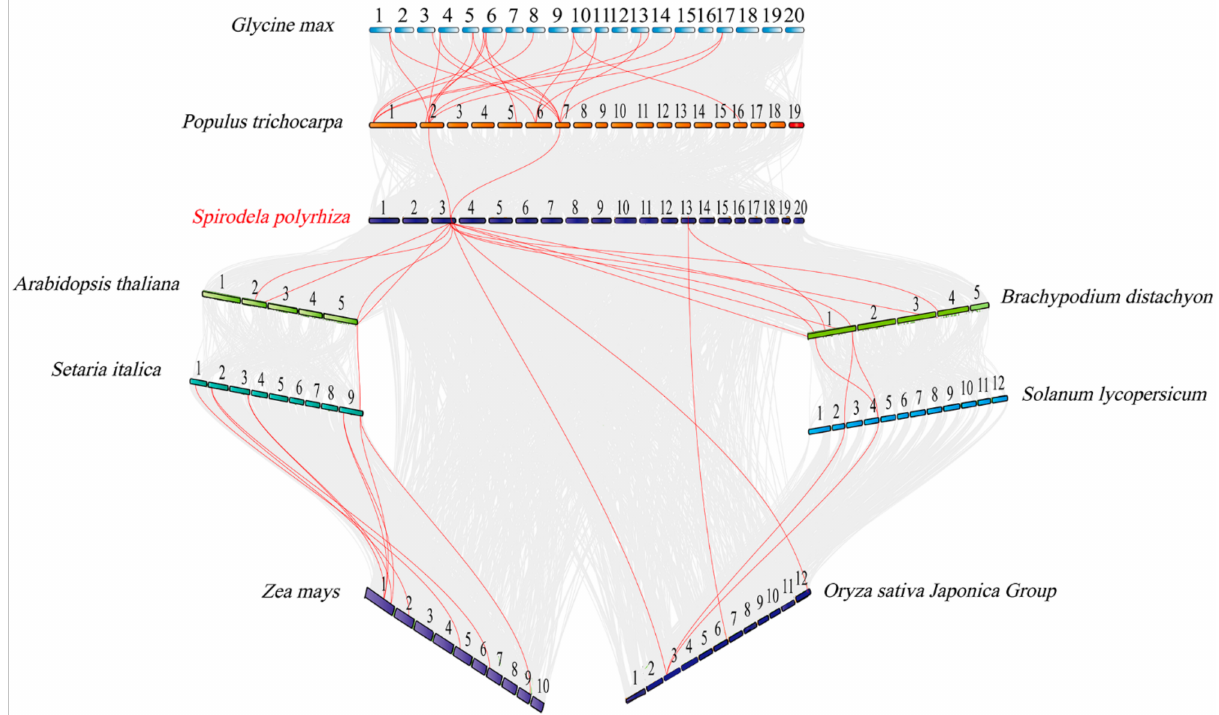
Figure 4. Synteny relationship of Nramp genes pairs among S. polyrhiza and eight other species. The red represents the synteny genes, and the gray lines show the collinear blocks of the plant genome. The chromosome number is labeled at the top of each